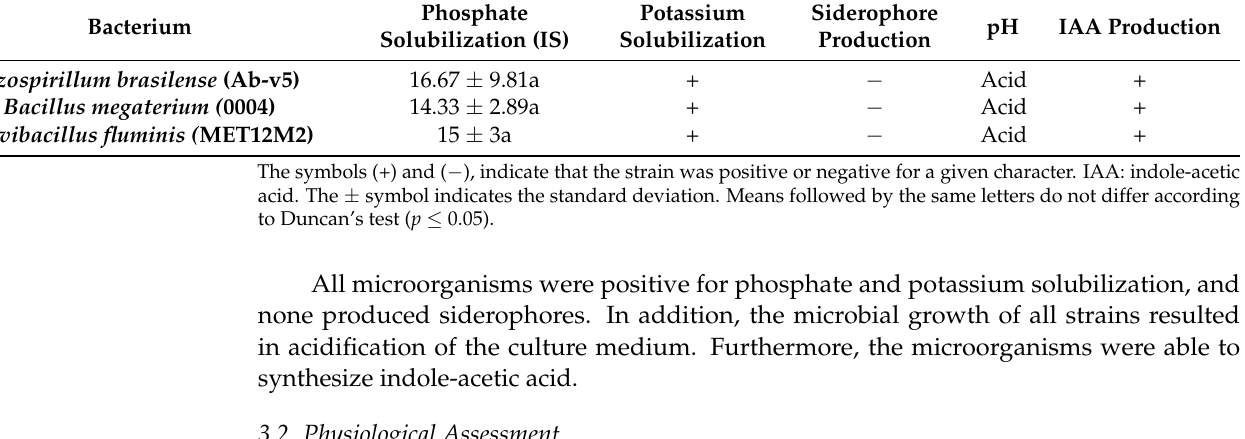
Table 2. Results of in vitro tests for growth promotion. Phosphate Bacterium Solubilization (IS)